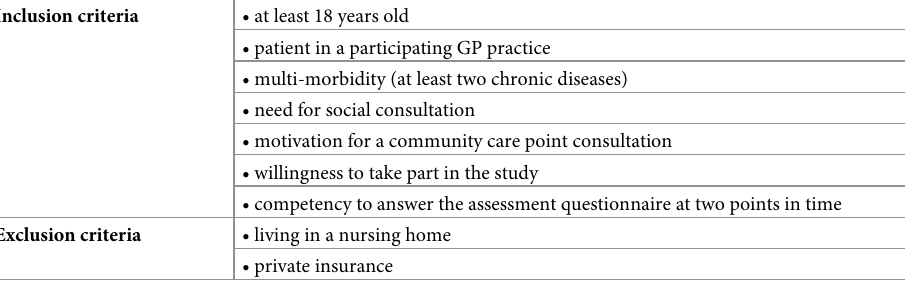
Table 1. Inclusion and exclusion criteria for